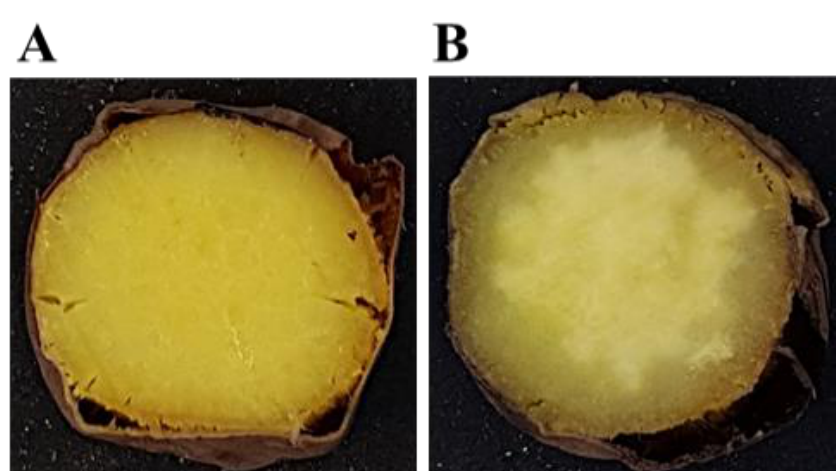
Figure 4. ( A ) Cross-section of baked sweet potato completely decomposed by amylase, and ( B ) cross-section of baked sweet potato with starch, owing to incomplete starch degradation.